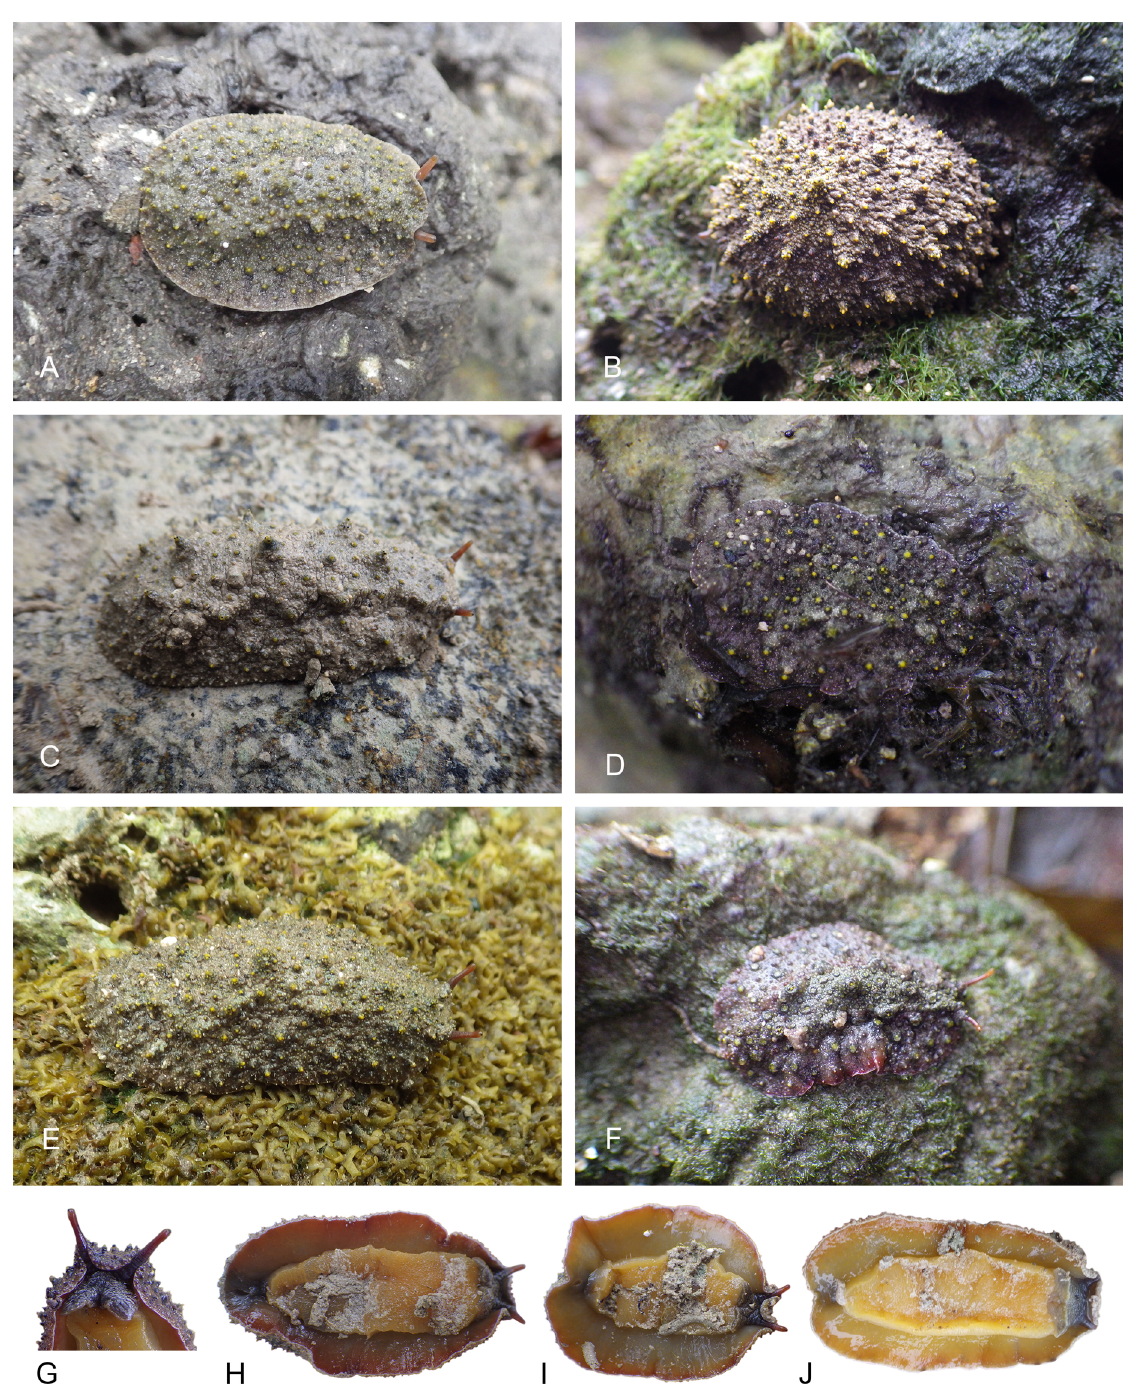
Fig. 31. Paromoionchis boholensis gen. et sp. nov., unit #1, live animals. A . Holotype, dorsal view, 28 mm long [3288], Philippines, Bohol (PNM 041266). B . Dorsal view, 26 mm long [3609], Philippines, Luzon (PNM 041267). C . Dorsal view, 38 mm long [3417], Philippines, Bohol (PNM 041270). D . Dorsal view, 17 mm long [3283], Philippines, Bohol (PNM 041268). E . Dorsal view, 30 mm long [3372], Philippines, Bohol (PNM 041269). F . Dorsal view, 17 mm long [3619], Philippines, Bohol (PNM 041268). G . Ventral view, same as E. H . Ventral view, 38 mm long [3422], Philippines, Bohol (PNM 041270). I . Ventral view, 32 mm long [3413], Philippines, Bohol (PNM 041270). J . Ventral view, same as